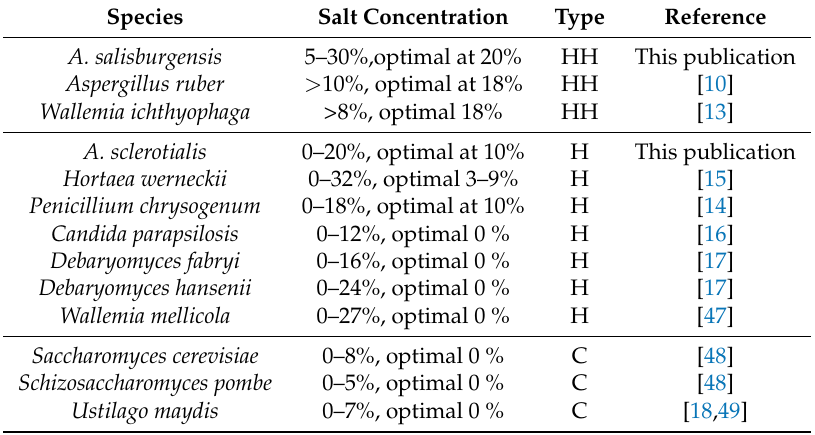
Table 1. List of genomes compared in this study. For each species, the name, the range of salt tolerance, the type of tolerance, and reference are listed. H: halotolerant, HH: halophile, C: control.